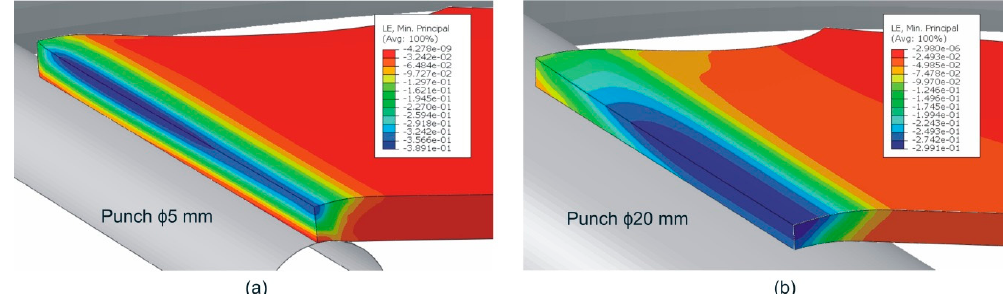
Figure 8. Numerical thickness strain contours in a stage near failure by necking for cylindrical punches of ( a ) φ 5 mm and ( b ) φ 20 mm (one quarter model). of ( a ) φ 5 mm and ( b ) φ 20 mm (one quarter model).